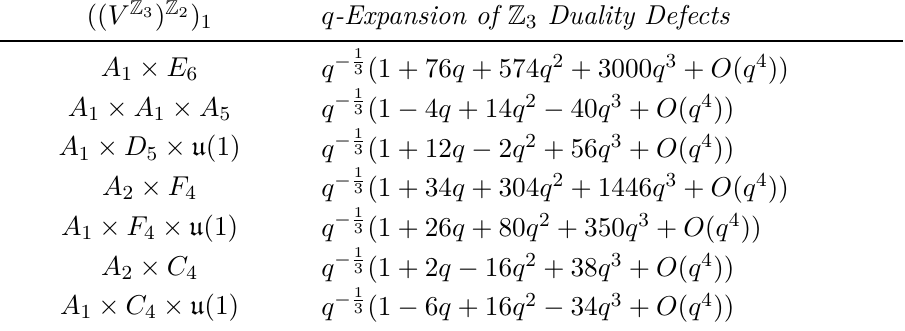
Table 5 . List of the defect partition functions of order 3, with defect twisting time. On the left are the weight one subspaces of ( V Z 3 ) Z 2 ; these are Lie algebras, not invariant lattices. On the right are q -expansions of the defect partition functions from equations (4.20)–(4.26). The first 3 defects are lifted from outer A 2 lattice actions, the next 4 are lifted from outer E 6 lattice